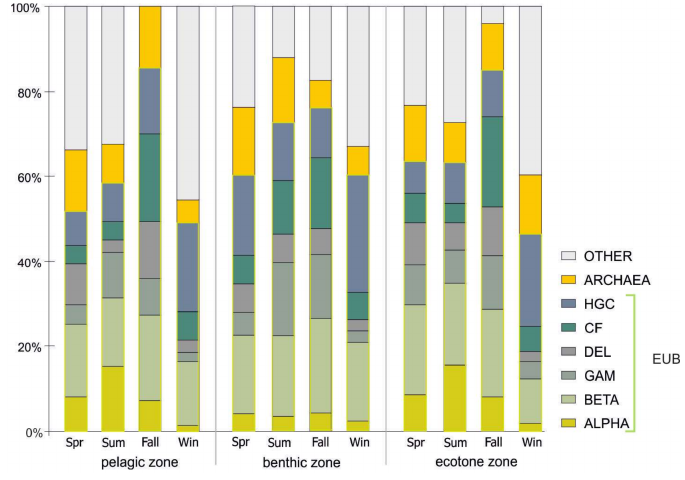
Figure 4. Changes in the taxonomic composition of bacterial communities in the Suchar lakes II, III, and IV Sphagnum mat-surrounded peat bog